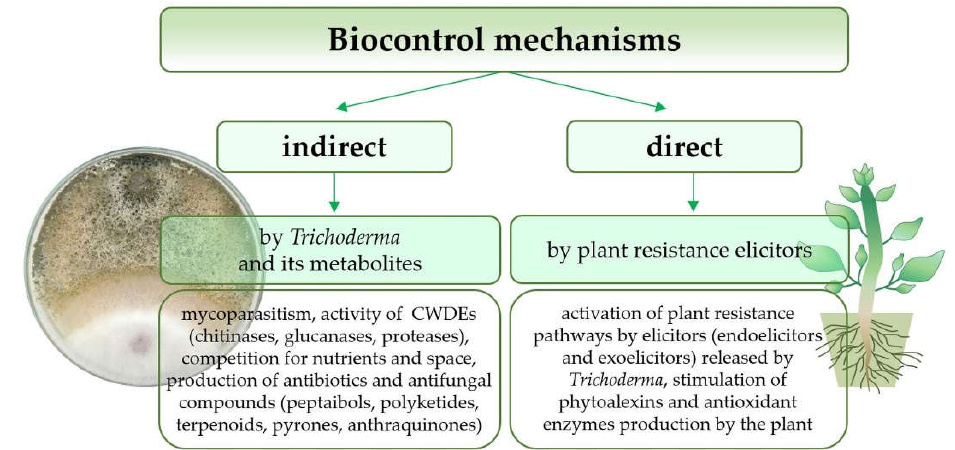
Figure 2. Biocontrol mechanisms used by the Trichoderma genus against fungal pathogens.